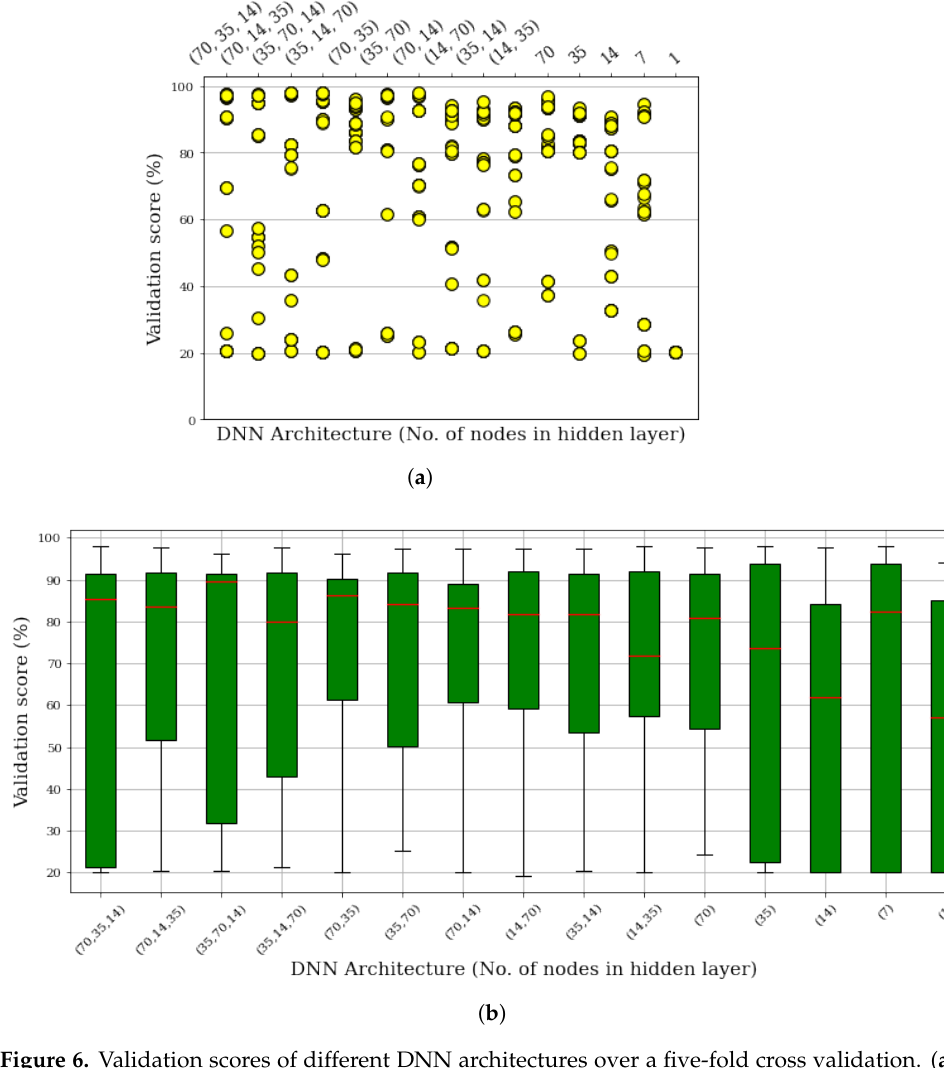
Figure 6. Validation scores of different DNN architectures over a five-fold cross validation. ( a ) A complete assessment view; ( b ) boxplot of each DNN architecture’s